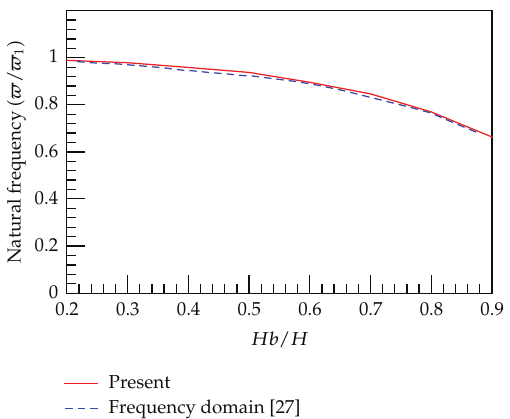
Figure 6: Distribution of the first-order natural frequency for di ff erent ba ffl e length.